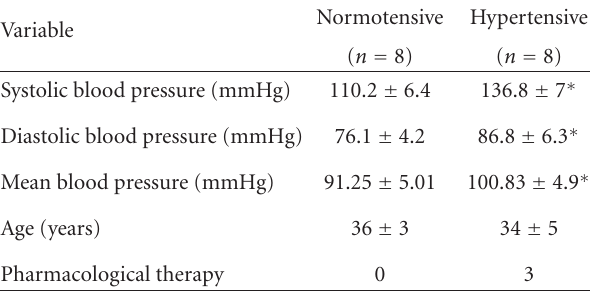
Table 1: Clinical characteristics of